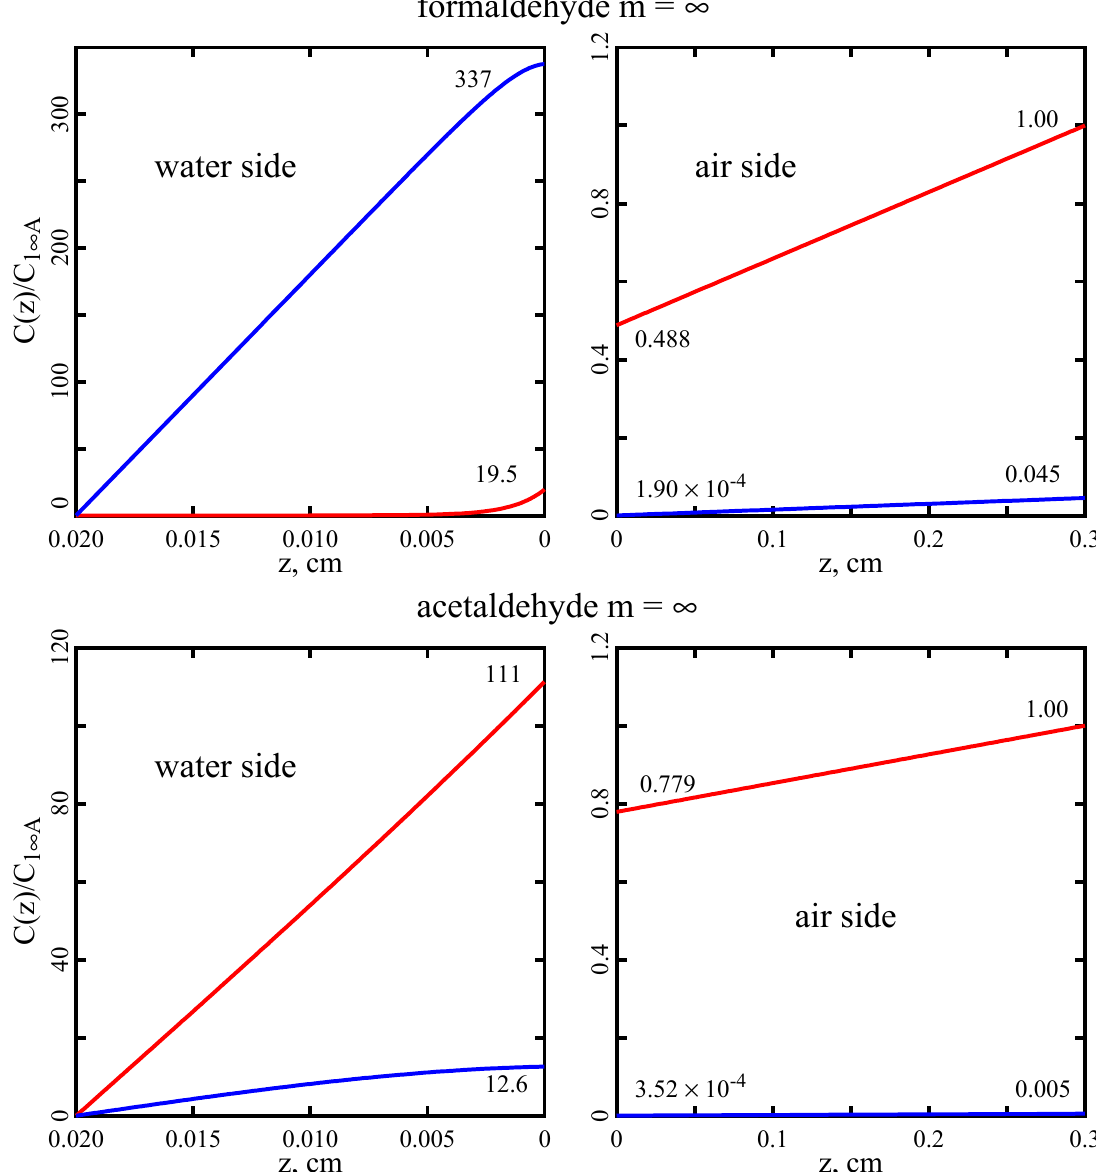
Figure 6. Concentration profiles through the films as calculated in model A4 with m → ∞ and corresponding to the calculations summarized in Table 6. All concentrations are normalized to C 1 ∞ A = 1. Red = aldehyde concentration, blue = diol concentration. Intercepts at z = 0 and L are shown.